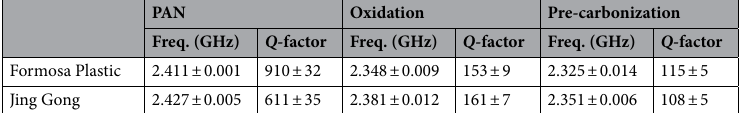
Table 1. The extrapolated resonant frequencies and Q -factors of two brands with 100% volumetric percentages in the three stages: PAN, oxidation, and pre-carbonization.